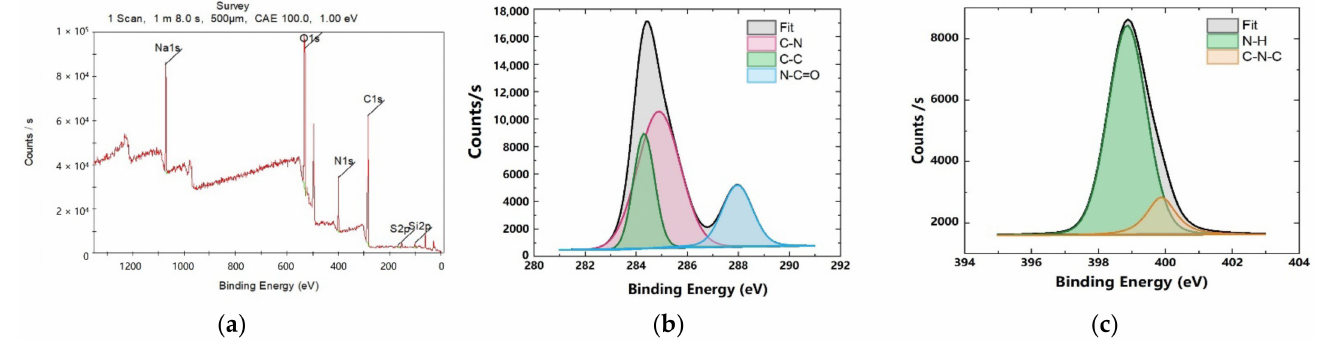
Figure 6. XPS analysis results of CQDs. ( a ) XPS full spectrum of CQDs; ( b ) C1s spectrum of CQDs; ( c ) N1s spectrum of CQDs.